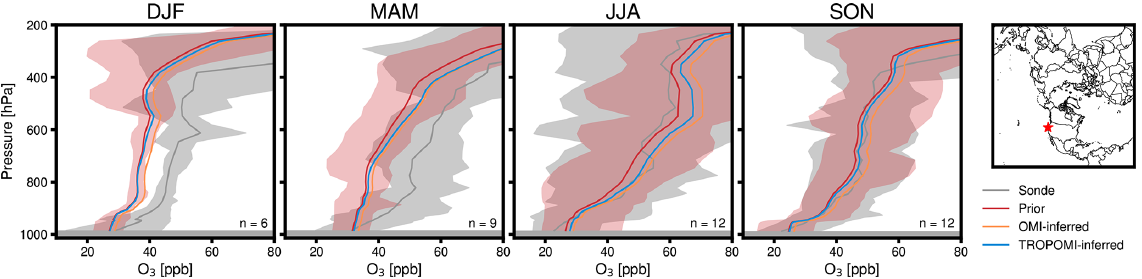
Figure 12. Season-average vertical O 3 concentration profiles modeled by CMAQ and measured by ozonesondes launched at Trinidad Head, California, in 2019. Vertical distributions are shown for simulations using prior emissions (Prior), lightning and anthropogenic NO x emissions inferred with OMI data (OMI-inferred), and lightning and anthropogenic NO x emissions inferred with TROPOMI data (TROPOMI-inferred). Modeled season-average profiles are shown during winter (DJF), spring (MAM), summer (JJA), and fall (SON) for days and times matching ozonesonde launches. Shading around sonde and prior emissions profiles represent the maximum and minimum O 3 at each pressure level. Map shows location of the Trinidad Head launch